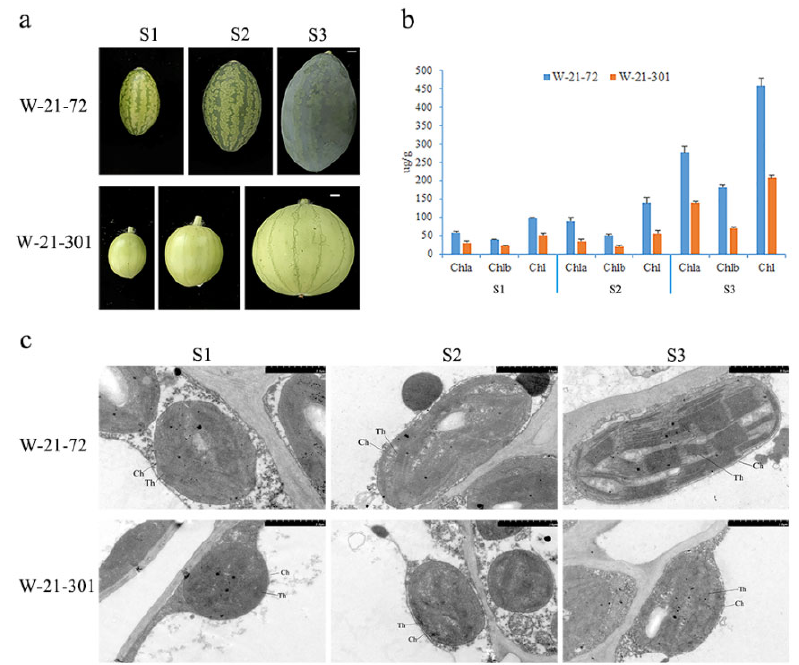
Figure 5 . Phenotype analysis of the fruit in two cultivars of watermelon. ( a ) Fruit phenotype of two cultivars at three stages. S1, S2 and S3 represent the stages before, during, and after the change in pericarp color in the cultivar “W ‐ 21 ‐ 72”, respectively. ( b ) Chl content in the pericarp of the fruit at three stages. ( c ) Chloroplast ultrastructure (bars, 0.2 μ m) in the pericarp of the fruit at three stages. Ch, chloroplast. Th, thylakoid.